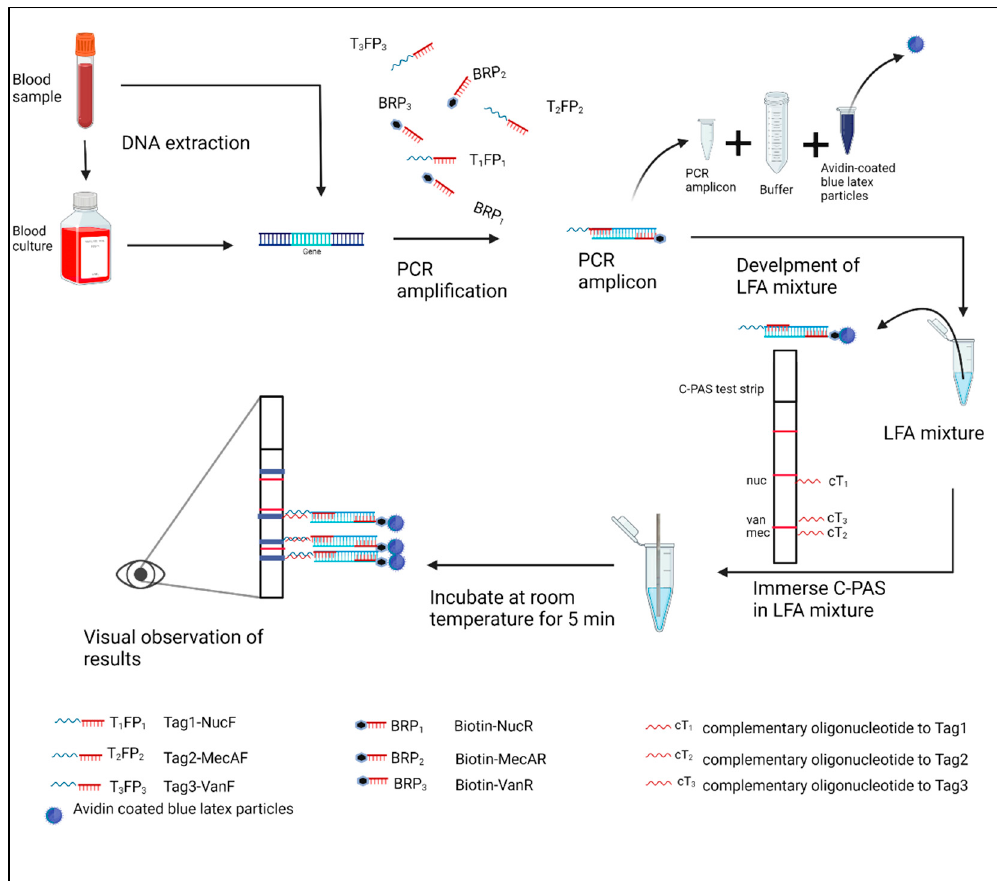
Figure 1. Schematic diagram of the of the multiplex polymerase chain reaction (PCR)-based DNA lateral flow assay (MBDLFA) workflow; created with biorender.com. The designed chromatography-printed array strip (C-PAS) containing complementary oligonucleotides to each single-stranded tag and indicating the expected positions of the generated colored line specific to each tag is shown. The red lines in strip represent position markers that help localization of test lines. Tag1-NucF, Tag2-MecAF, Tag3-VanF: single-stranded oligonucleotides-tagged forward primers for amplification of nuc , mec A, and van genes, respectively; Biotin-NucR, Biotin-MecAR, Biotin-VanR: biotin-labelled reverse primers for amplification of nuc , mec A, and van genes, respectively